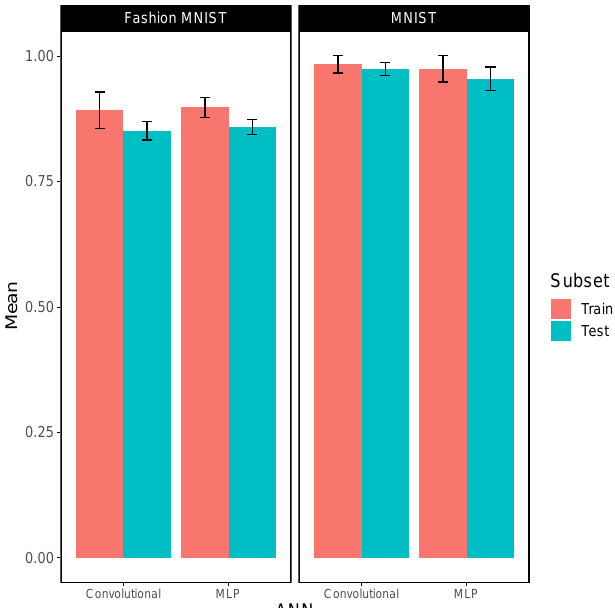
Figure 14. Mean categorical accuracy for MNIST and Fashion MNIST datasets using MLP and CNN, including error bars using one standard